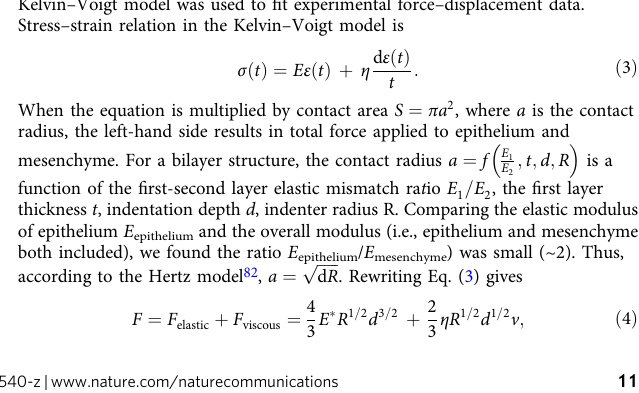
Fig. 5 De fi cient cell rearrangements in Wnt5a − / − mutants. a The Wnt5a − / − mutant mandibular arch is comparatively short and broad by OPT. b A fi nite element model incorporating the spatial variation of Wnt5a − / − mutant cell cycle time, Young ’ s modulus and viscosity was employed to simulate 4 h of growth starting from the actual 19 somite stage Wnt5a − / − mutant mandibular arch shape compared to the actual 21 somite stage Wnt5a − / − mutant arch. c Ratio of rostrocaudal to proximodistal axis length (RC/PD) was comparatively better for fi nite element simulation of Wnt5a − / − mutant growth than for WT. d , e Cells of H2B-GFP transgenic embryos were tracked by 4D light sheet microscopy and, according to a random walk model, persistence of cell movements (persistent time ( d )) and direction (angle from the mean ( e )) were diminished in Wnt5a − / − mutants. CDF, cumulative distribution function. f Epithelial T1 transitions in the Wnt5a − / − mutant mandibular arch did not tend to converge and extend the middle region as in WT (compare with Fig. 3b). g Angular change in long axis among resolving tetrads was diminished in Wnt5a − / − mutant epithelium ( n = lateral arch epithelium in each of 2 – 5 embryos per condition, asterisks indicate p < 0.05, Student ’ s t -test). h Distribution of mesenchymal cell face numbers was shifted rightward to higher values for Wnt5a − / − mutant mesenchyme ( n = 2 Wnt5a − / − embryos, 92 middle cells, 146 distal cells, error bars denote s.e.m.). i Mesenchymal cells in the